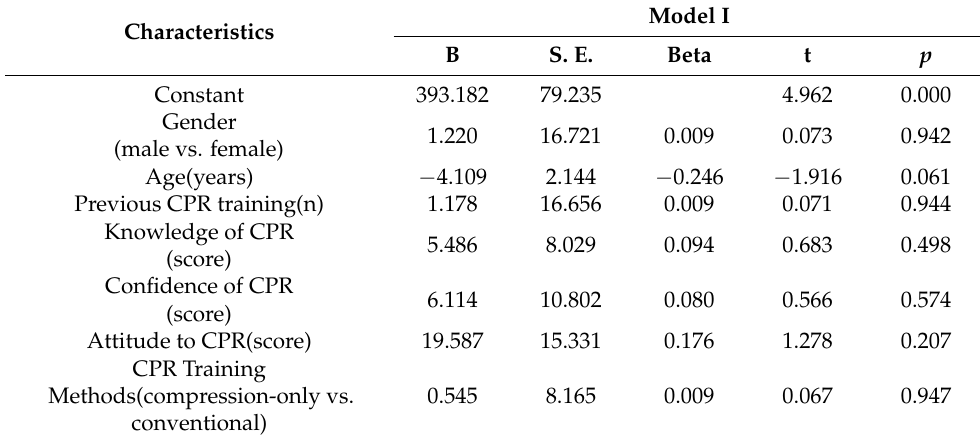
Table 4. The effects of participants’ characteristics on the accuracy of CPR skills at right after